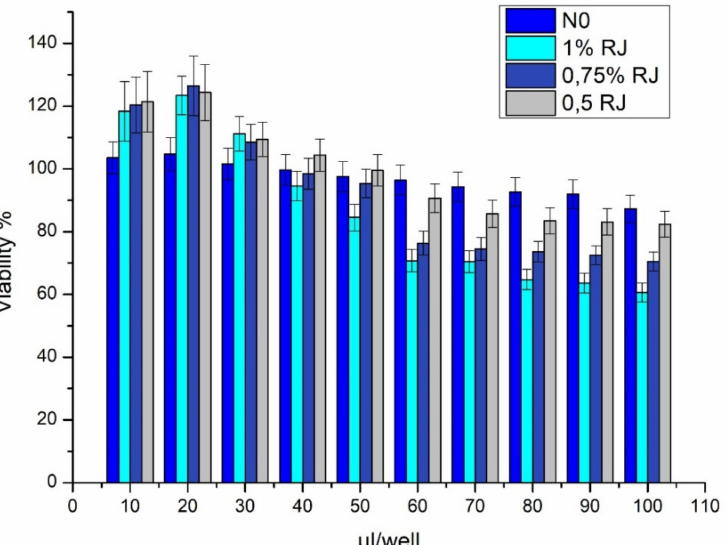
Figure 4. Statens Seruminstitut rabbit cornea (SIRC) cell viability after 24-h incubation with microemul- sions. The error bars represent the standard deviation of measurements for cell viability ( n =